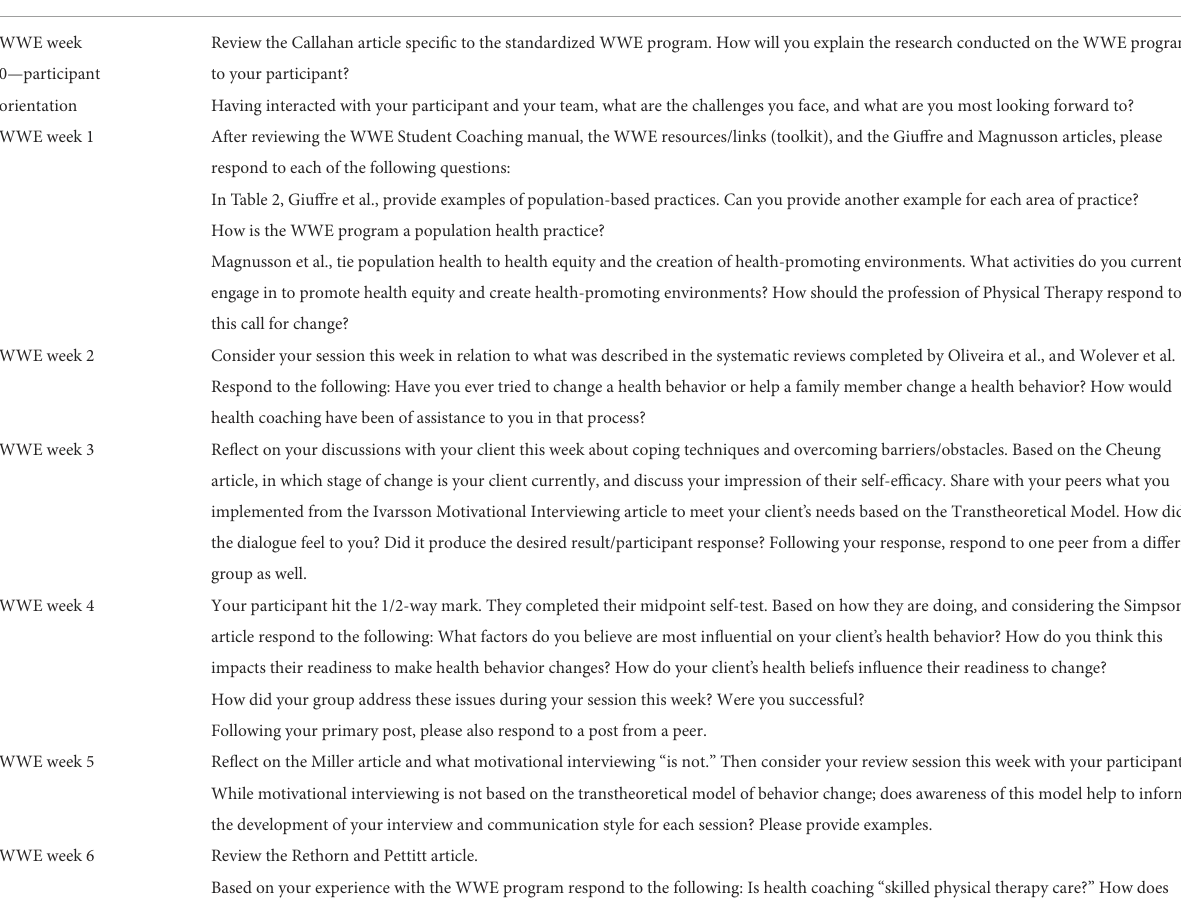
TABLE 2 Prompts for student reflections in the learning management